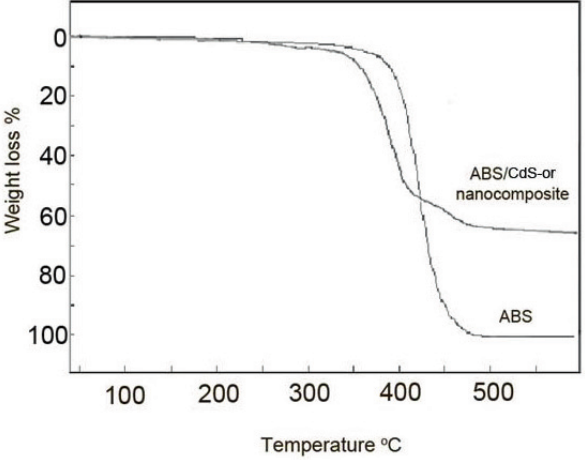
Figure 5. TGA curve of (a) pure ABS and (b) ABS/CdS-or nanocomposite.